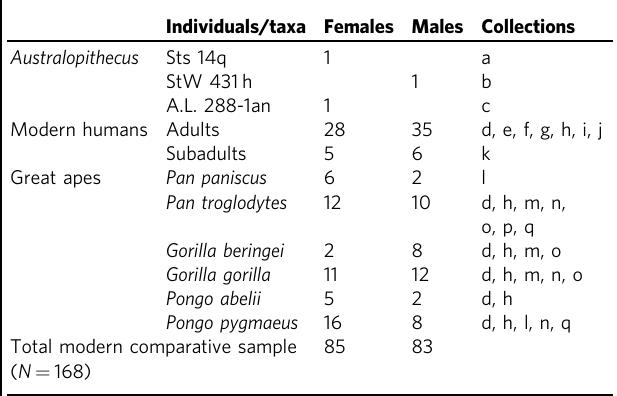
Table 2 List of fossil sacra and modern comparative